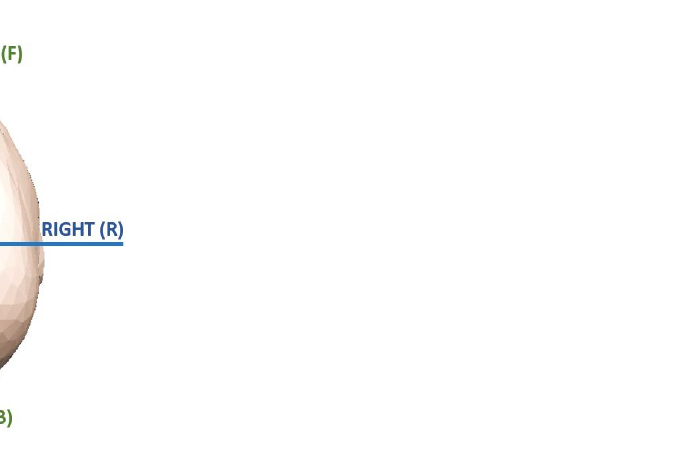
Figure 3. Subdivision of the head into four regions (horizontal view): front left (FL), front right (FR), back left (BL), and back right